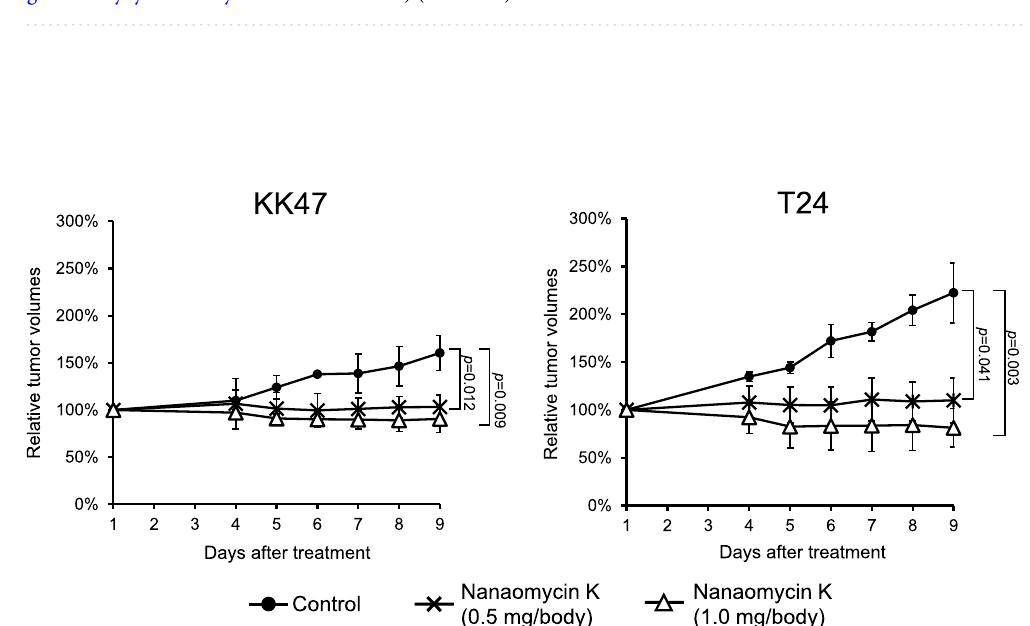
Figure 6. In vivo tumor inhibitory effects of nanaomycin K. Two bladder cancer cell lines, KK47 and T24, were subcutaneously inoculated into BALB/c nu/nu mice. After tumor growth was confirmed, mice were intratumorally treated with 0.5 mg/body nanaomycin K, 1.0 mg/body nanaomycin K, or vehicle control at day 1 (n = 4). After treatment, the tumor volume was measured for 9 days. The tumor volume of each mouse was standardized by that at day 1 and the tumor growth ratio is shown in the graphs (n = 4, average ± SE